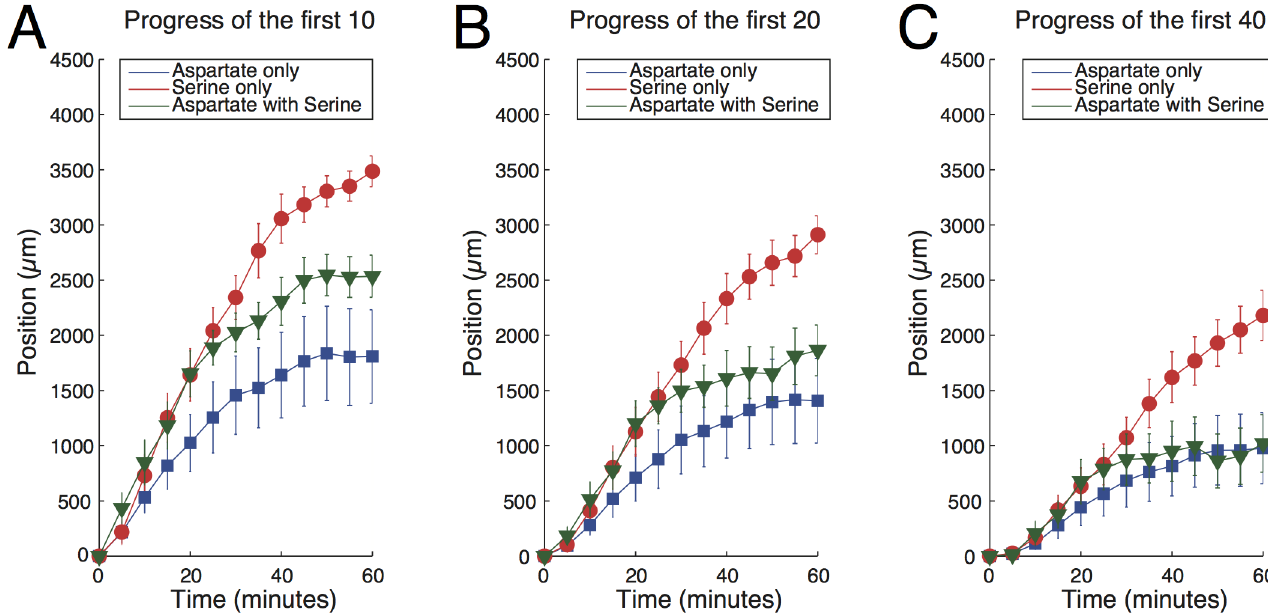
Fig 6. The bacterial forefronts vs time. We show the position of the (A) 10 th , (B) 20 th and (C) 40 th most advanced bacteria for a gradient of serine (red), a gradient of aspartate (blue) and a gradient of aspartate with a 30 μ M background of serine (green). Curves represent the mean of five experiments and error bars represent the error on the estimation of the